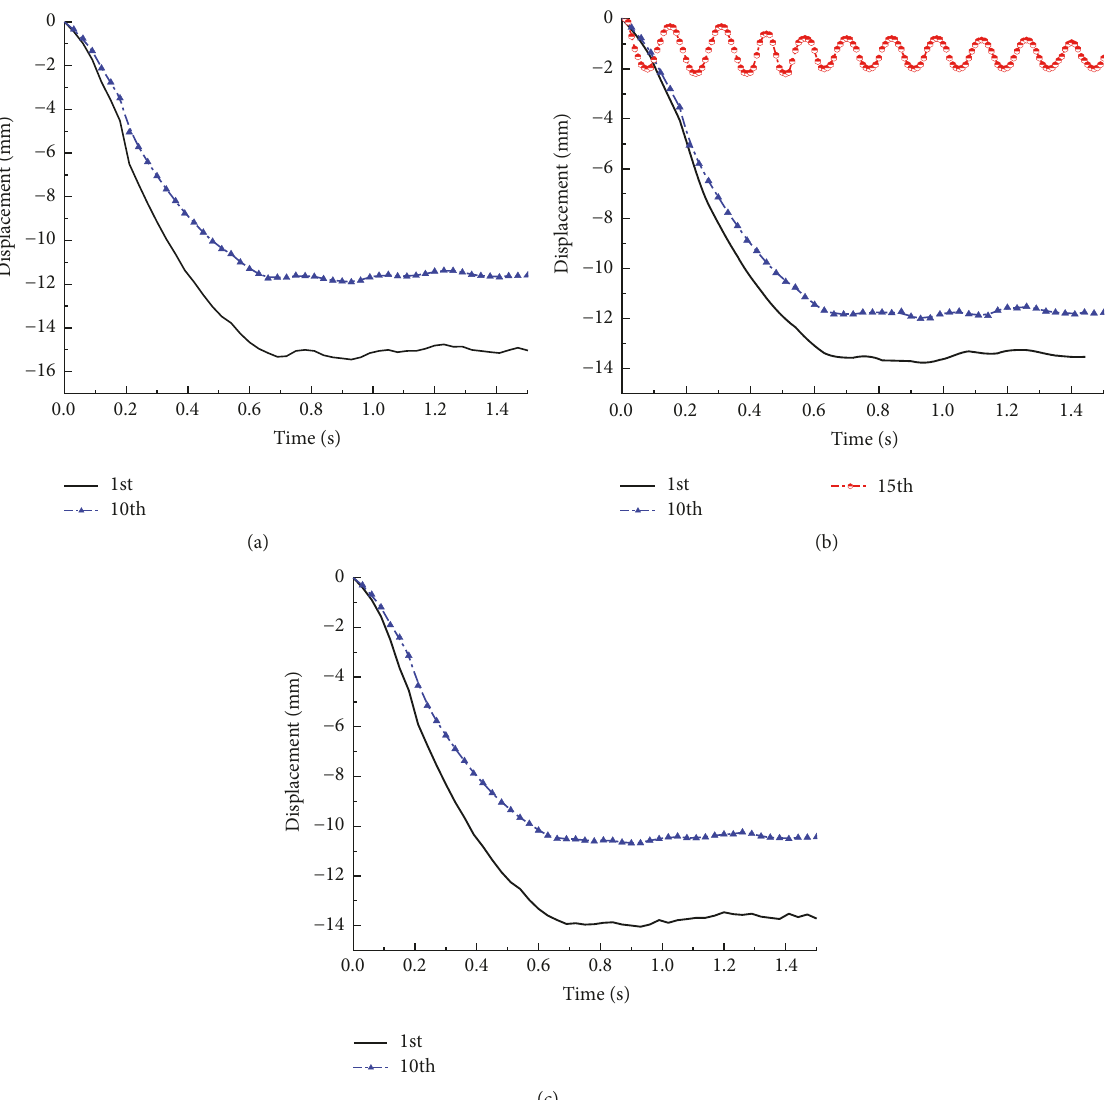
Figure 10: Removal of central shear wall in building: (a) 10-story model; (b) 15-story model; (c) 10-story model of the 8-degree seismic design; (a)–(c) vertical displacement of the joint at the top of the removed column on the 𝑥